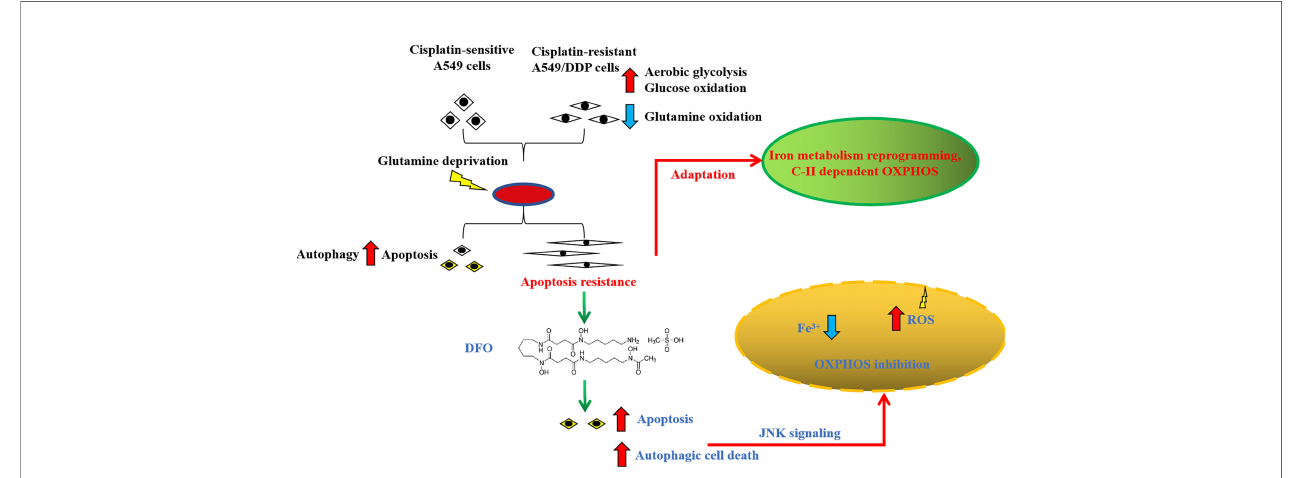
FIGURE 8 | Schematic summarization of the interaction among glutamine deprivation, chemotherapy, and DFO treatment and their effects on JNK signaling- mediated autophagic cell death and